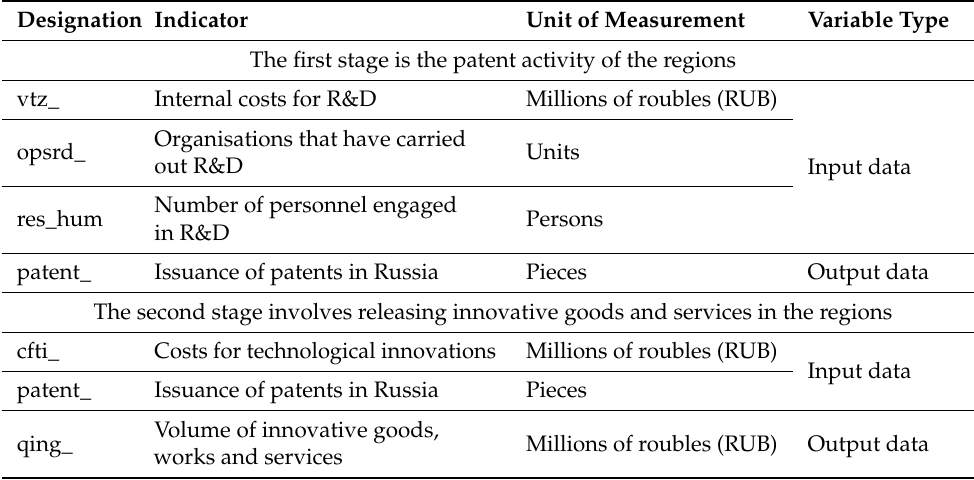
Table 3. Model parameters (compiled by the